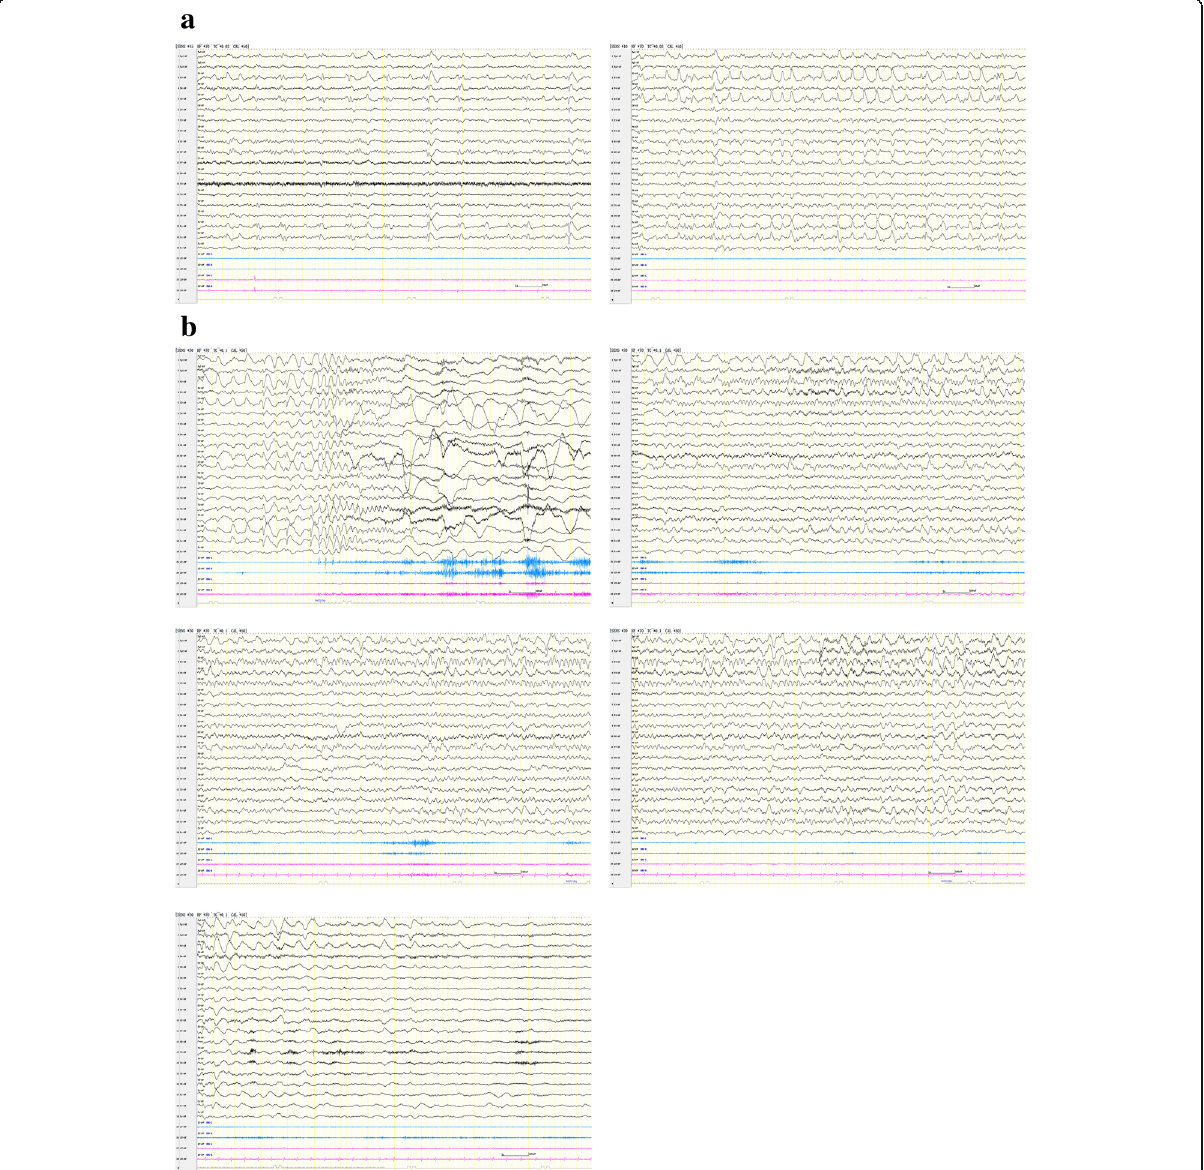
Fig. 1 Video electroencephalography recordings. a EEG background is normal. Interictal EEG showed left forehead spike waves, sharp waves, and spike (or sharp) slow wave complexes. b Ictal EEG shows rhythmic sharp slow wave complexes in the left anterior head region, followed by low- voltage fast activity and rhythmic spike waves; these were contaminated by movements or muscle artifacts, and evolved to the left hemisphere, with occasional insertion of slow waves. The whole procedure lasted for 1 – 2 min. Moreover, scared facial expressions, hypermotor seizure were observed clinically (lasting for about 1 – 2 min). EEG,